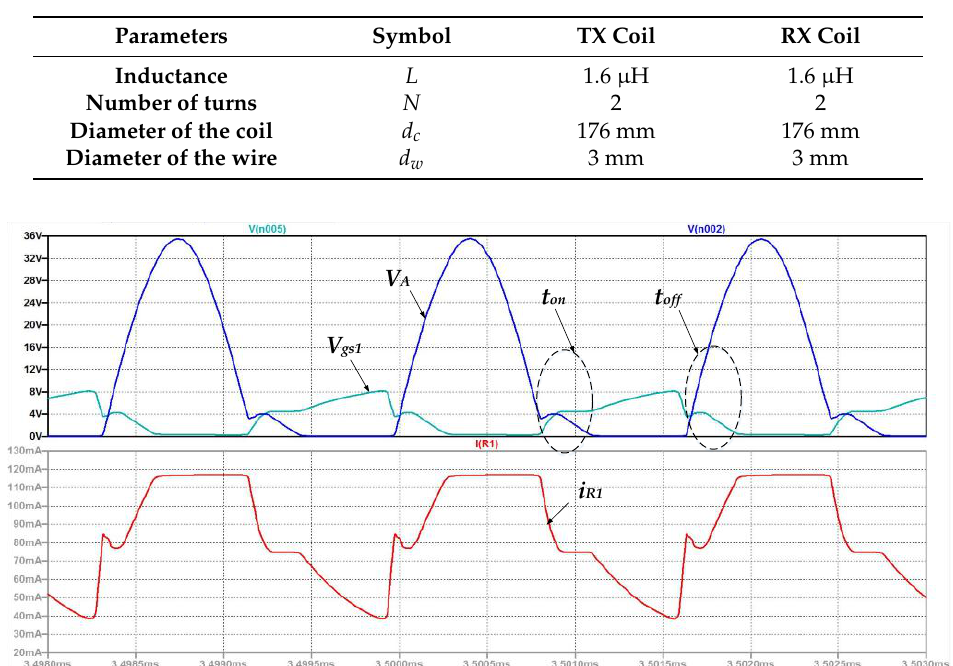
Figure 6. Voltage and current waveforms of a traditional circuit simulation at V DC = 12 V.